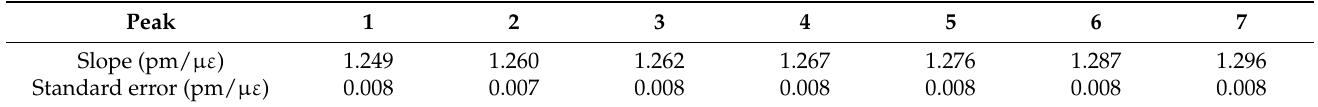
Figure 7. The spectra of peaks 1 – 7 ( a – g ) and Bragg wavelength shift ( h ) in terms of the strain from 0% to 1.05% for FBG 2 in the second regime. Table 2. Linear fit of peaks 1–7 of FBG 2 in the first regime as a function of strain from 0% to